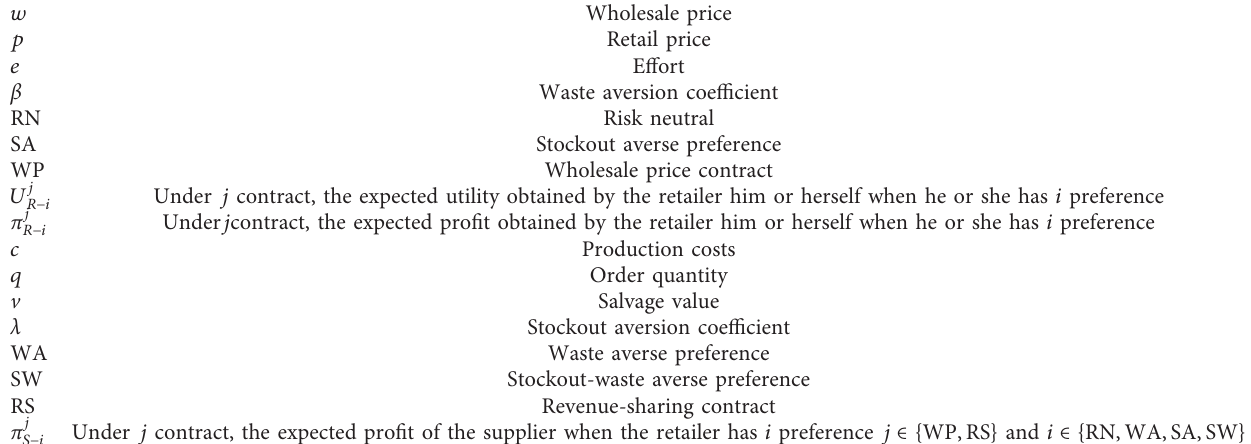
Table 1: Symbols and